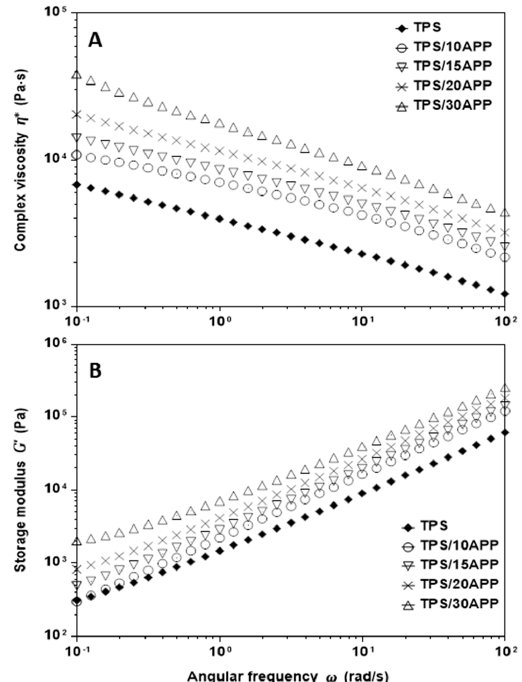
Figure 6. Complex viscosity ( A ) and storage modulus ( B ) as a function of the oscillatory frequency of TPS and TPS/APP composites with varied contents.